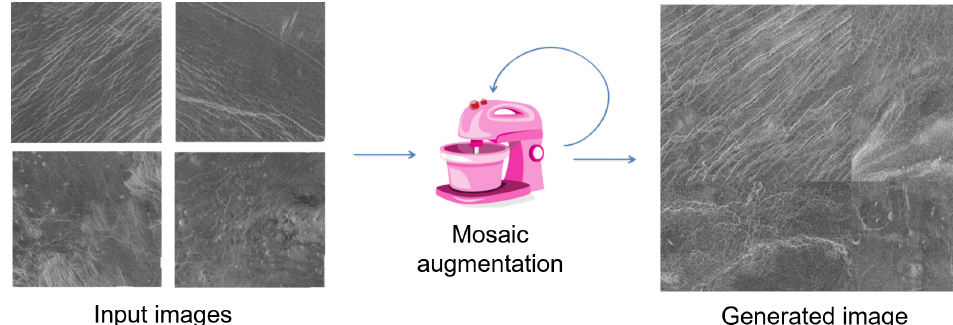
Figure 13. Concept of mosaic augmentation